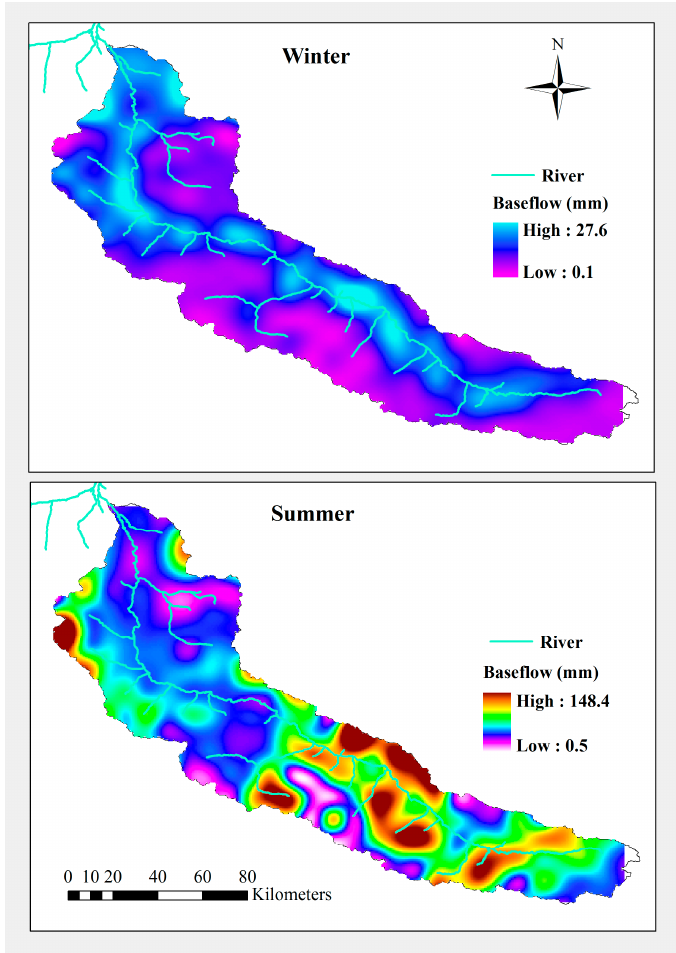
Figure 7. The spatial distributions of baseflow in the winter and summer half of the year, during 1996–2009.